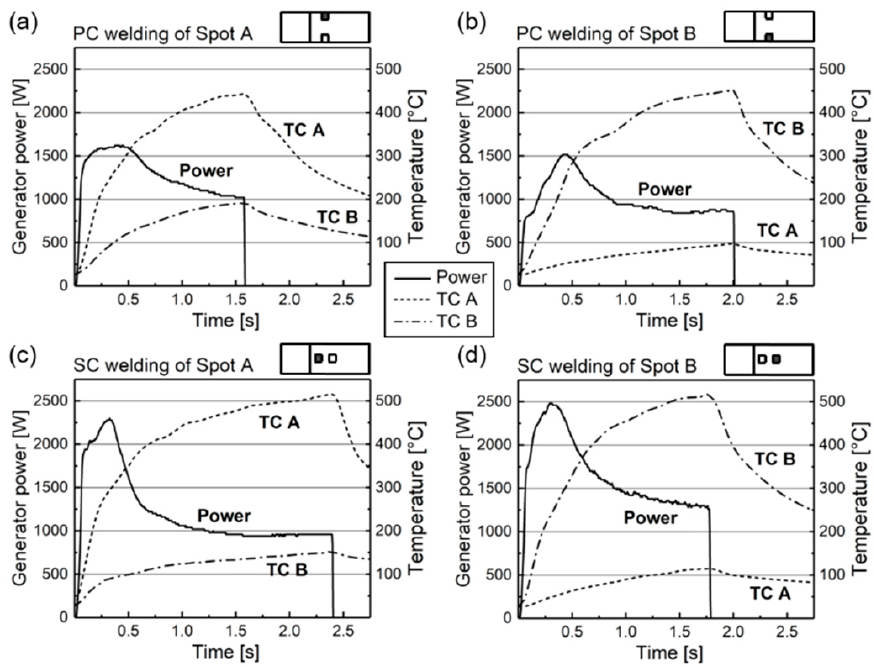
Figure 6. Characteristic curves of the generator powers and thermocouple temperatures over time for the ( a ) first and ( b ) second PC welding, as well as ( c ) first and ( d ) second SC welding. Although the parameters used for both spots were identical, their welding times differed considerably for both connection types. The standard deviation of the welding times was low, albeit with a longer second weld for PC and a longer first weld for SC. For SC, the shorter welding time of Spot B is due to the clamping punches on both sides and the Spot A already welded. Increased power is required to achieve the nominal oscillation amplitude due to the limited movement of the aluminum sheet. Compared to Spot A, the same amount of energy at high power input results in a shorter welding time for Spot B. In the case of PC, the increased power required to weld the first spot can be attributed to the needed energy input in the additional clamping area. The joining partners are able to move against each other, which is no longer possible during welding of the second spot. This results in the opposite development of the welding times for the two spot arrangements. Based on these results, the presence of a previously welded spot did not allow a general prediction of the welding time of a second spot. The specific configuration is crucial. The peak temperatures generated at a weld spot were independent of the welding time and the power-time curve of the generator. The amount of welding energy, which was the same for both weld spots of the two configurations, ultimately determined the peak temperature in the joining zone. Table 4 shows a comparison of the simultaneously taken thermocouple and infrared camera readings. For PC welds, an average temperature difference of 177.5 ◦ C for Spot A ture differences were seen to be 214 ◦ C and 196.4 ◦ C, respectively.